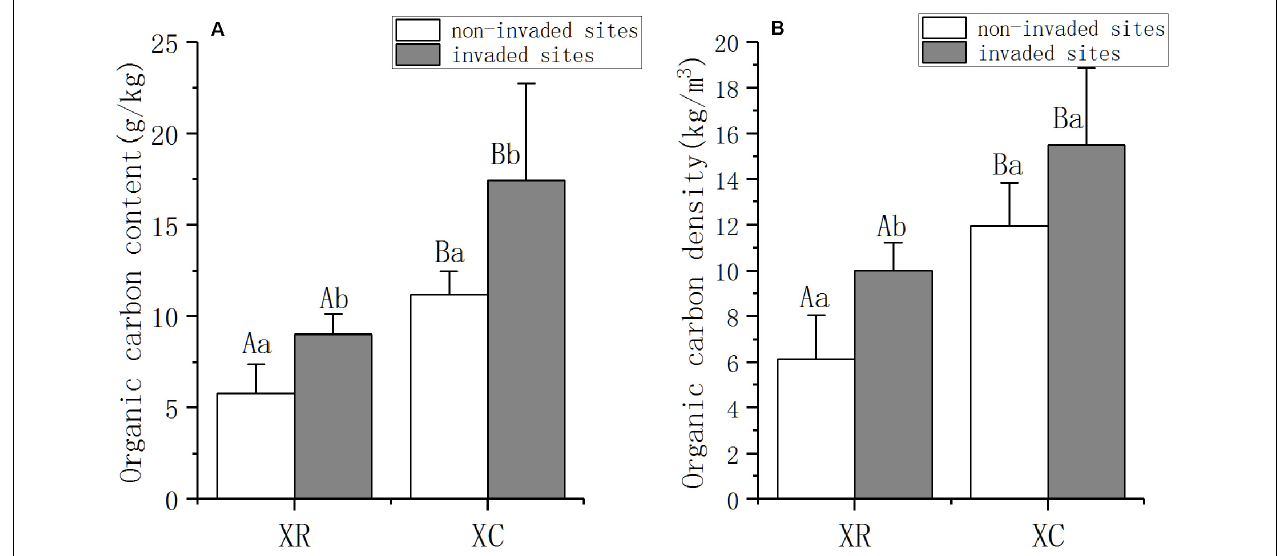
FIGURE 2 | SOC content (A) and density (B) (mean ± SD, standard deviation) in Xinxue River and Xinxue River Constructed Wetland in 2018. XR, Xinxue River; XC, Xinxue River Constructed wetland. Different superscript uppercase letters indicate statistically significant differences at α = 0.05 level between the river and constructed wetland. Different superscript lowercase letters indicate statistically significant differences at α = 0.05 level between invaded sites and non-invaded sites.